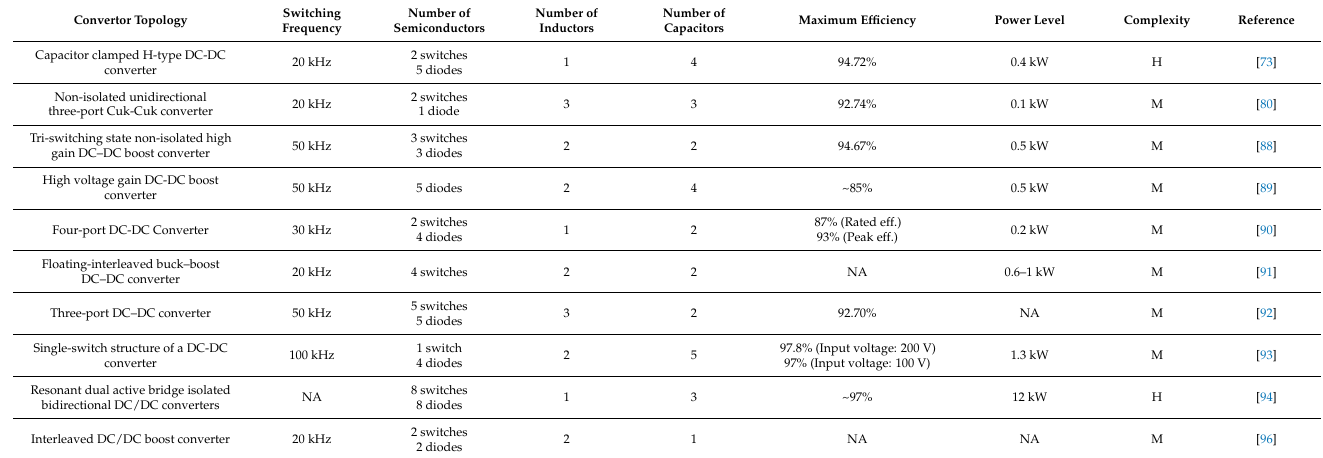
Table 2. Summary of characteristics of DC/DC converters topologies for FCEVs and